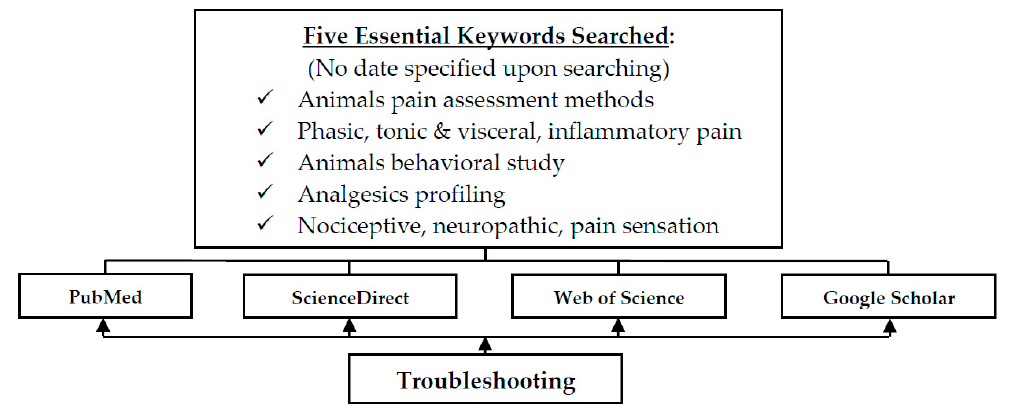
Figure 1. The literatures searching strategy of the present Figure 1 . The literatures searching strategy of the present review.